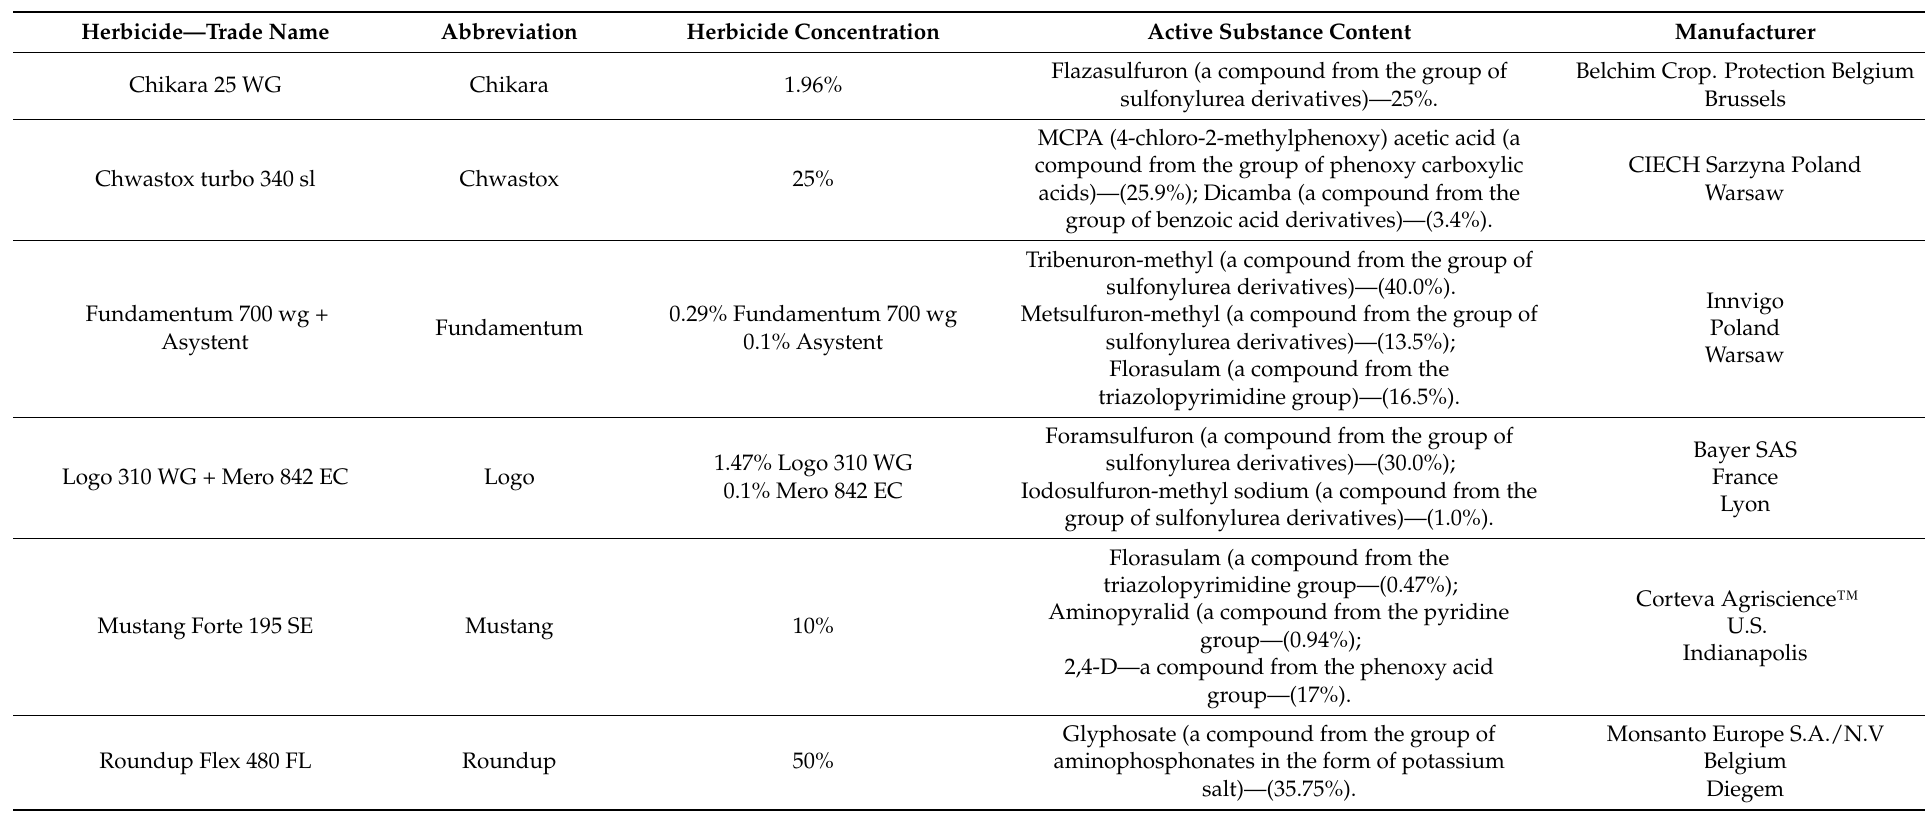
Table 1. Characteristics of herbicides used in the